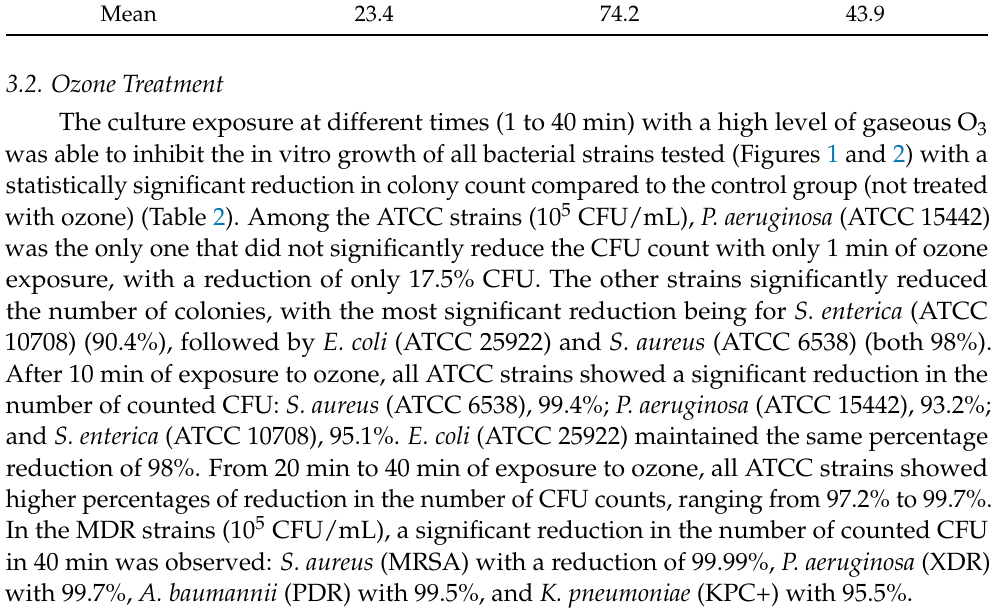
Table 2. Count and percentage reduction in the number of CFU in ATCC ( S. aureus (ATCC 6538), P. aeruginosa (ATCC 15442), S. enterica (ATCC 10708), and E. coli (ATCC 25922)) strains and multidrug- resistant S. aureus (MRSA), P. aeruginosa (XDR), A. baumannii (PDR), and K. pneumoniae (KPC+). ATCC strains (10 5 CFU/mL) after exposure to ozone (1, 10, 20, 30, and 40 min) and in bacterial suspensions of multi-resistant strains (10 5 CFU/mL) after exposure to ozone (40 min). Ozone Exposure Bacterial Strains